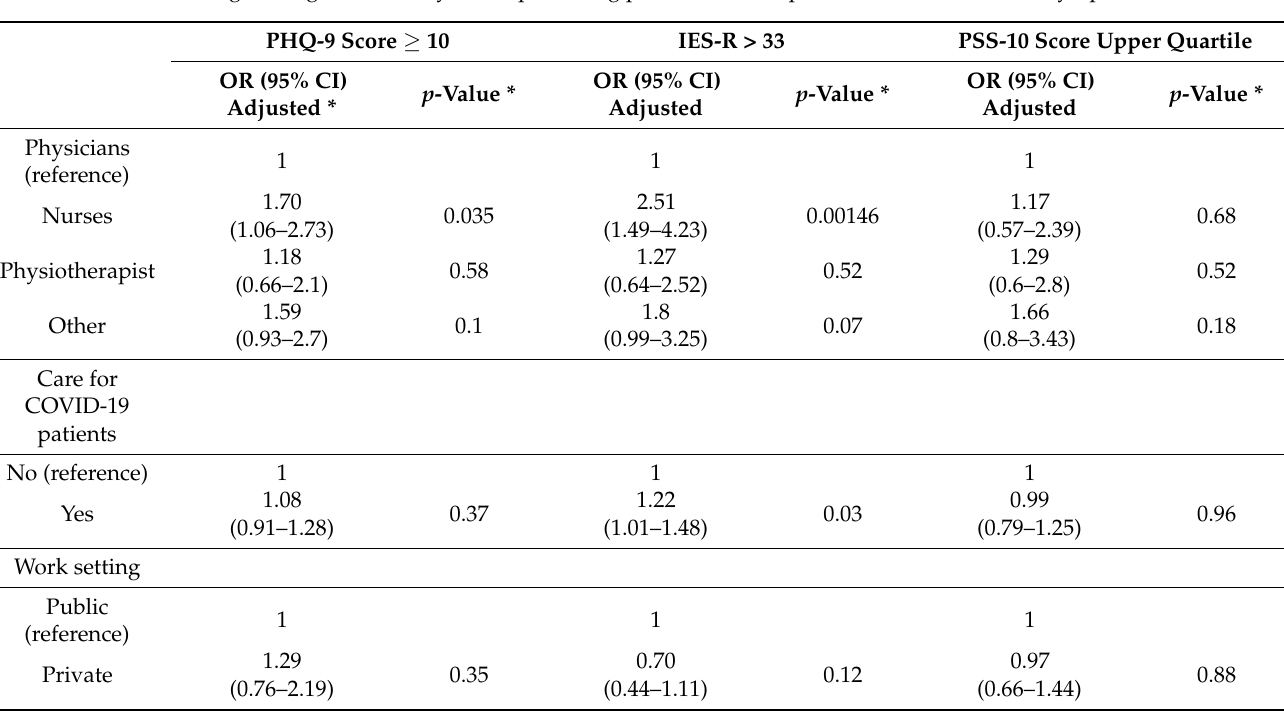
Table 2. Logistic regression analyses for predicting prevalence of depressive, PTSD and stress